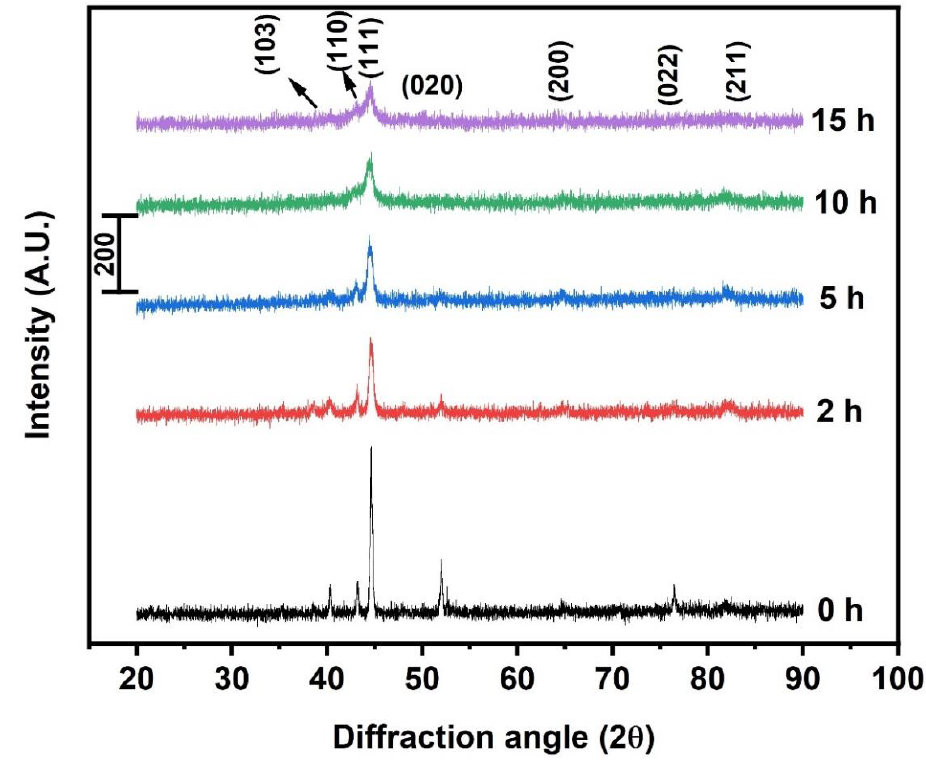
Figure 2. XRD spectra of 23Fe-21Cr-18Ni-20Ti-18Mn HEA powders milled at different time intervals.